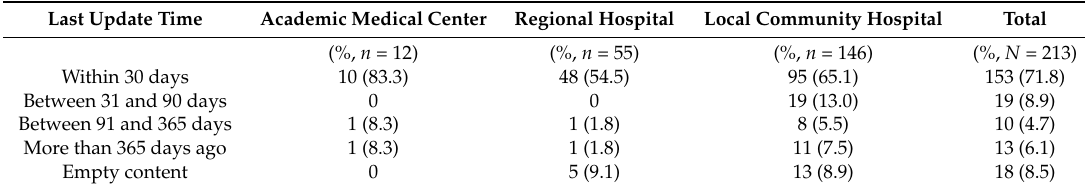
Table 2. Last update time on official Facebook fan pages of 213 hospitals in Taiwan.